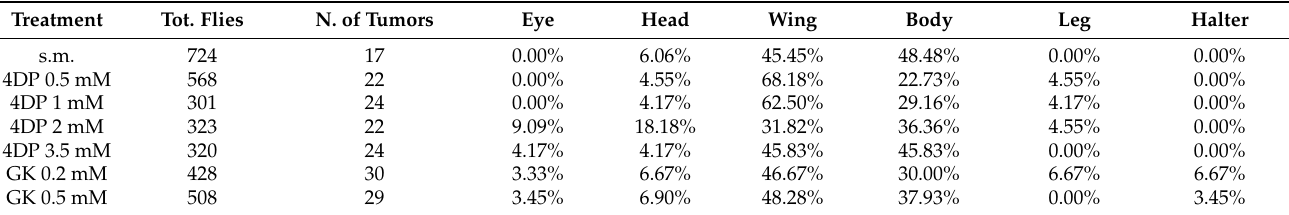
Table 1. Distribution of wts tumors induced by PLP inhibitors on wts/+ flies.